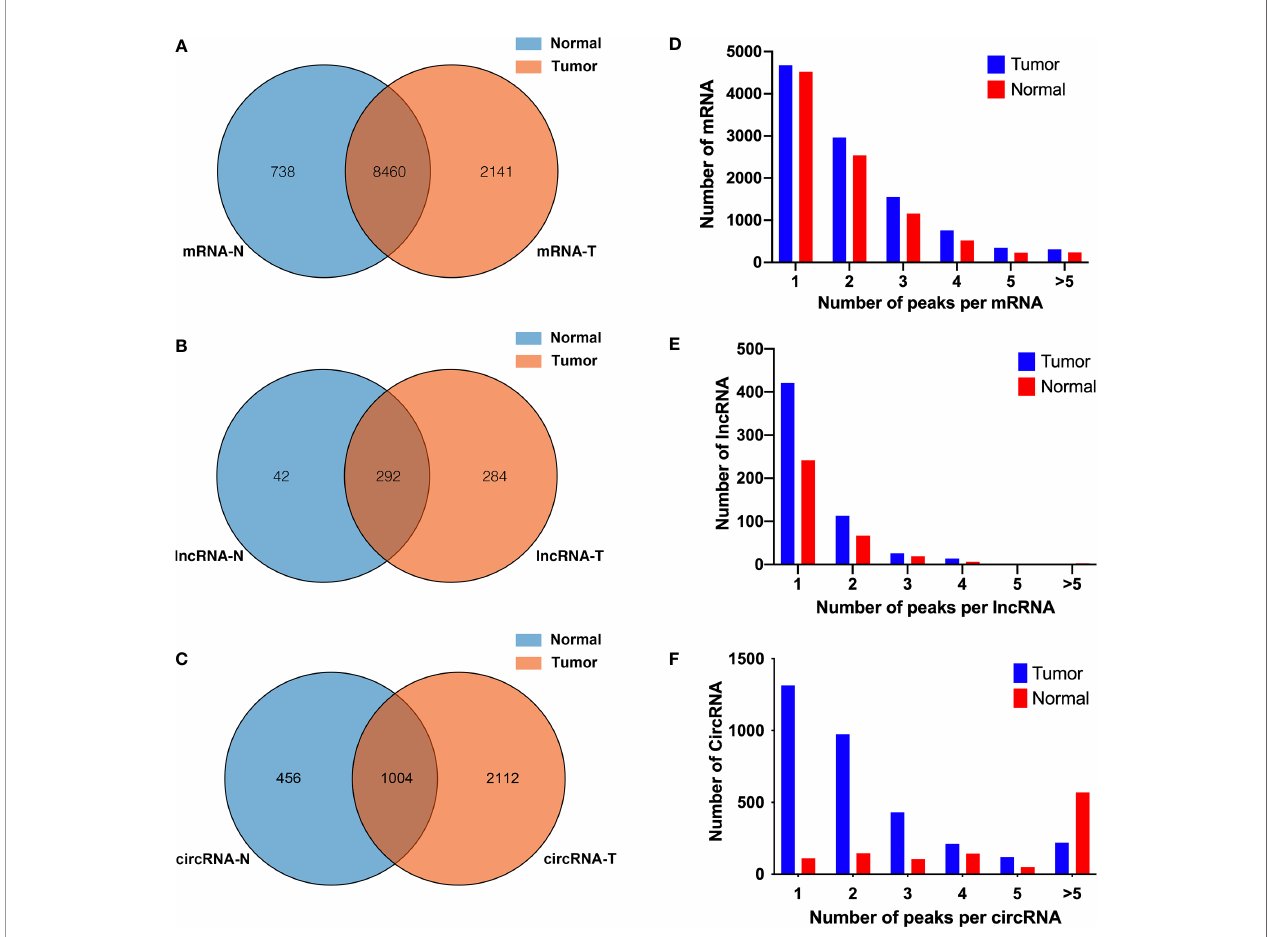
FIGURE 1 | Overview of N 6 -methyladenosine methylation within mRNAs, lncRNAs, and circRNAs in bladder cancer tissues and adjacent normal tissues. (A – C) Venn diagram showing the overlapped m6A peaks within mRNAs (A) , lncRNAs (B) , and circRNAs (C) between the two groups. (D – F) Proportion of mRNAs (D) , lncRNAs (E) , and circRNAs (F) harboring different numbers of m 6 A peaks in two